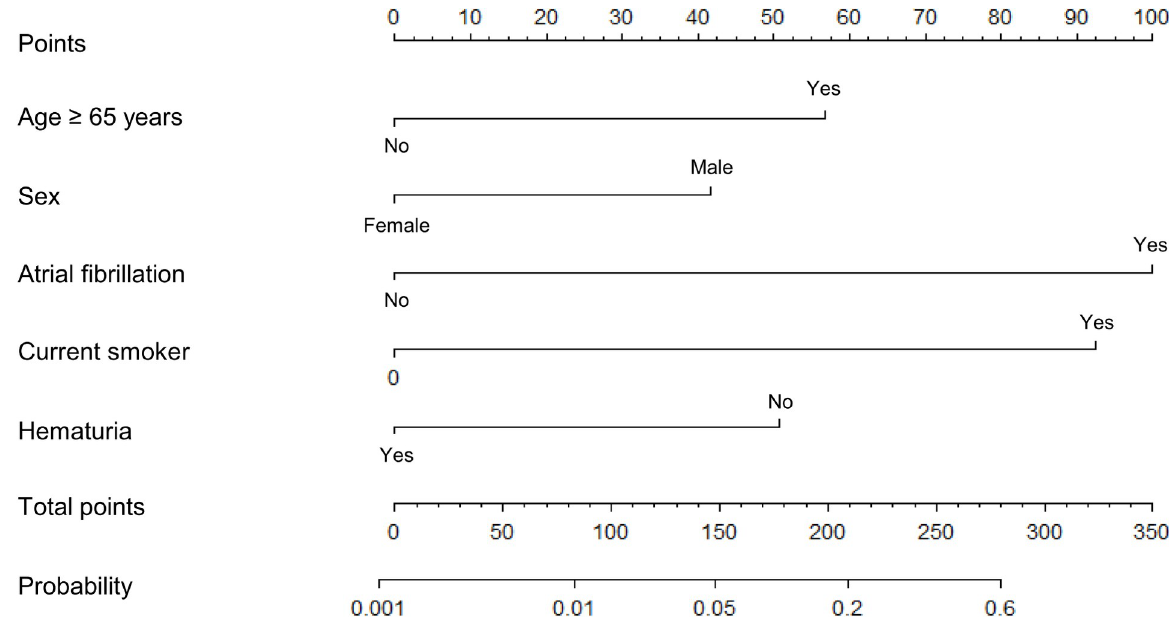
Fig 3. Nomogram to predict renal infarction in patients with flank